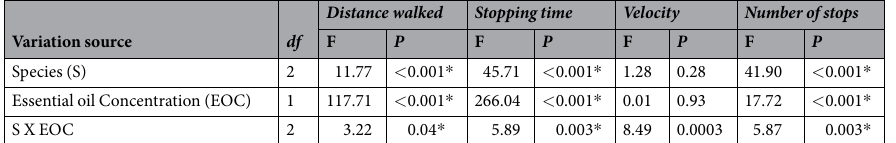
Table 3. Results of the analysis of variance for the general activity of 3 rd instar larvae groups of key lepidopteran pests (i.e., S . frugiperda and A . gemmatalis ) after 3, 6 and 16 h of exposure to the LC 10 or LC 50 of the S . guianensis essential oil estimated for each lepidopteran pest. S : insect species (i.e., S . frugiperda and A . gemmatalis ); EOC: LC 10 and LC 50 values of the S . guianensis essential oil estimated for each lepidopteran